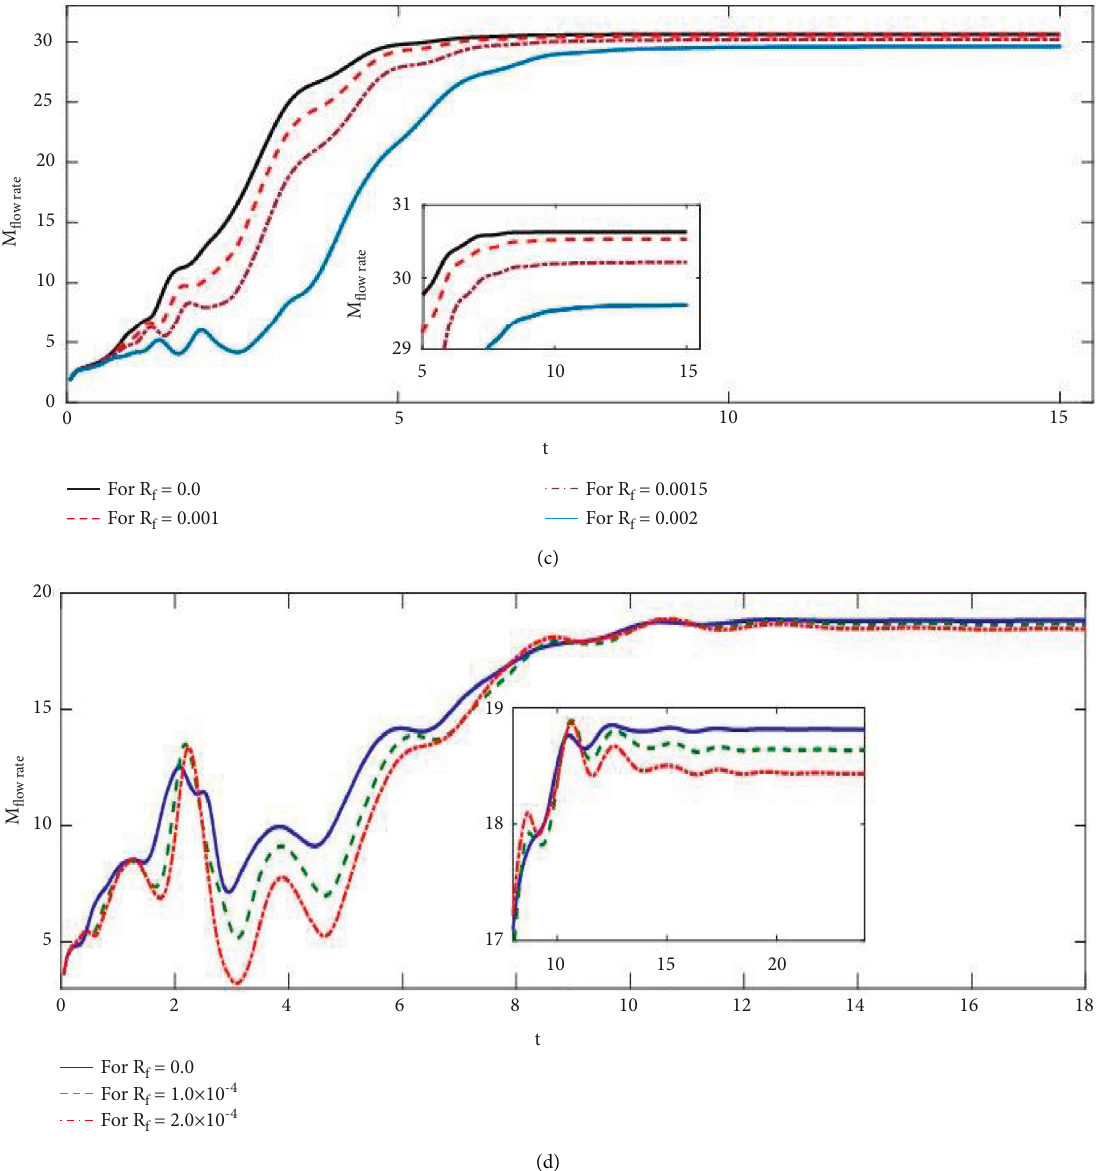
Figure 4: Mass flow rate with baffled length “ L ” � 0.25 for varying values of relaxation time ’ R Re � 2000. (d) For Re �